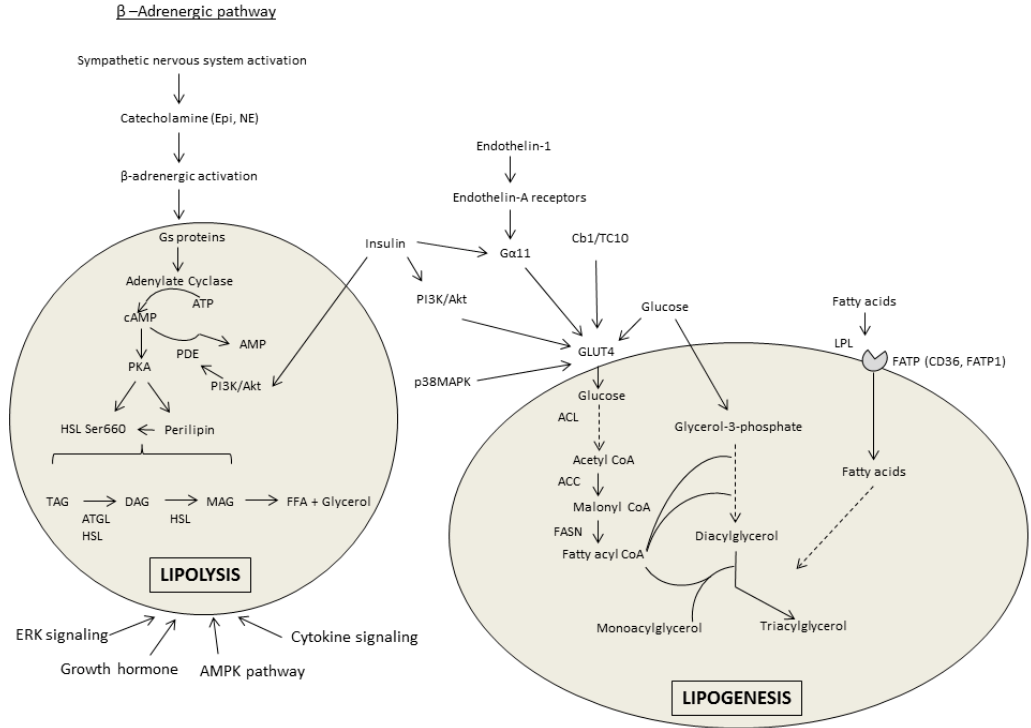
Figure 1. Overview of the lipolytic and lipogenic pathways in white adipose tissue. Lipolysis is predominantly activated by the β‐ adrenergic signaling pathway that increased the release of free fatty acids (FFA) and glycerol. Lipogenesis is stimulated by insulin and enhances the uptake of FFA and synthesis and storage of triacylglycerol (TAG). The shaded areas represent adipocytes. Abbreviations: epinephrine (Epi); norepinephrine (NE); cyclic adenosine monophosphate (cAMP); adenosine triphosphate (ATP); phosphodiesterase (PDE); protein kinase A (PKA); hormone sensitive lipase (HSL); phosphoinositide 3 ‐ kinase (PI3K); adipose tissue triglyceride lipase (ATGL); diacylglycerol (DAG); monoacylglycerol (MAG); extracellular signal related kinase (ERK); adenosine monophosphate kinase (AMPK); ATP ‐ citrate lyase (ACL); Acetyl Coenzyme A (CoA) carboxylase (ACC); fatty acid synthase (FASN); fatty acid transport proteins (FATPs); lipoprotein lipase (LPL); mitogen activated protein kinase (MAPK); cluster of differentiation 36 (CD36); glucose transporter ‐ 4 (GLUT4).